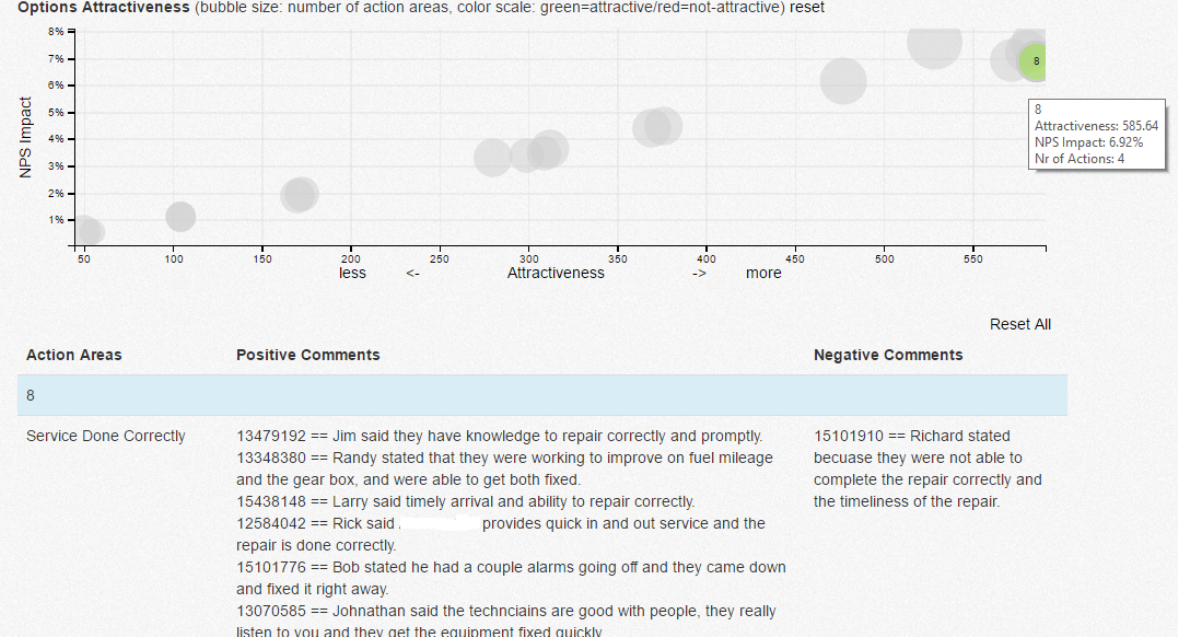
Figure 9. CLIRS2—step of inspecting the most impactful recommendation and comments associated with the